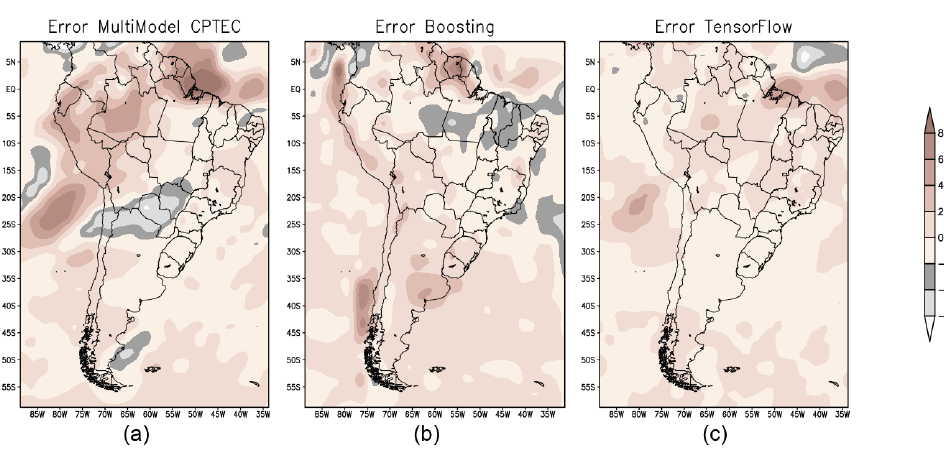
Figure 7. Error map for the autumn in South America to evaluate the performance of the forecast models: ( a ) BAM; ( b ) XGB; and ( c )